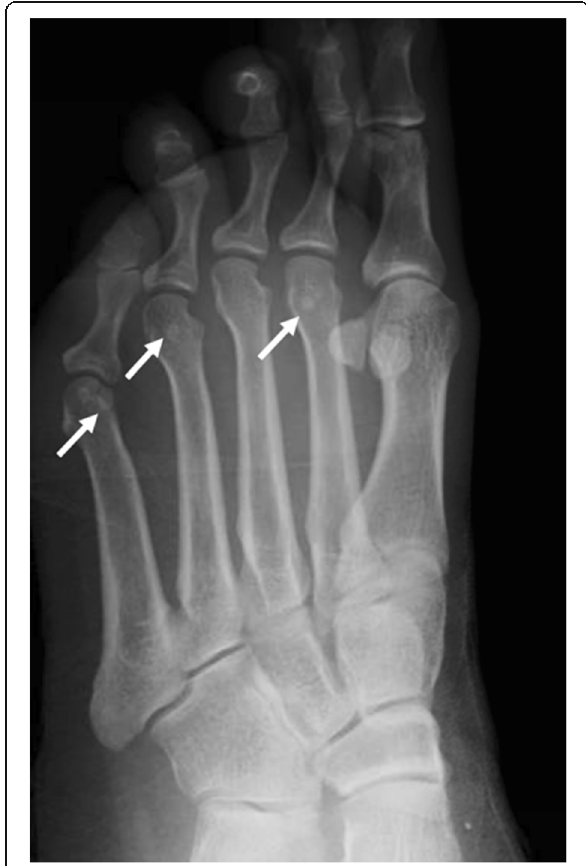
Fig. 14 Lesser metatarsal sesamoids. Oblique radiograph on a 42-year- old woman, referred after trauma of the ankle. Incidental finding of multiple lesser sesamoids in the fifth, fourth, and second metatarso- phalangeal joints (white arrows). The fifth is the most frequently found one. Lesser sesamoid pathology is very rare